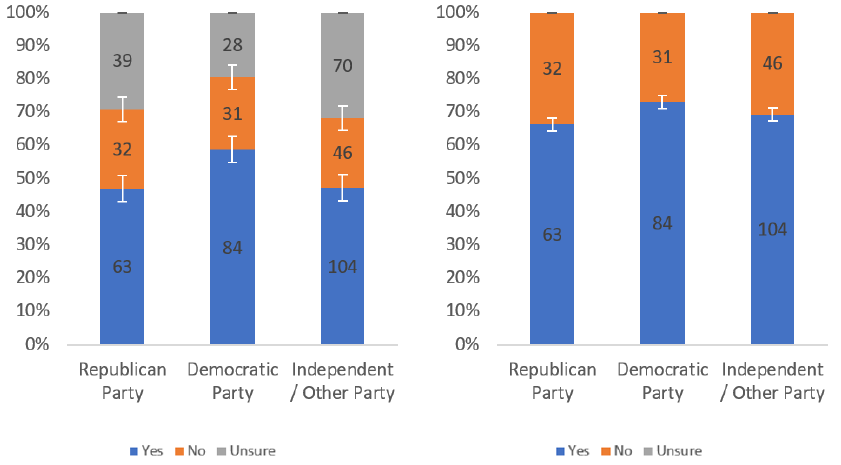
Figure 33. Responses regarding others’ willingness to review by party affiliation including ( left ) and excluding ( right ) unsure responses.